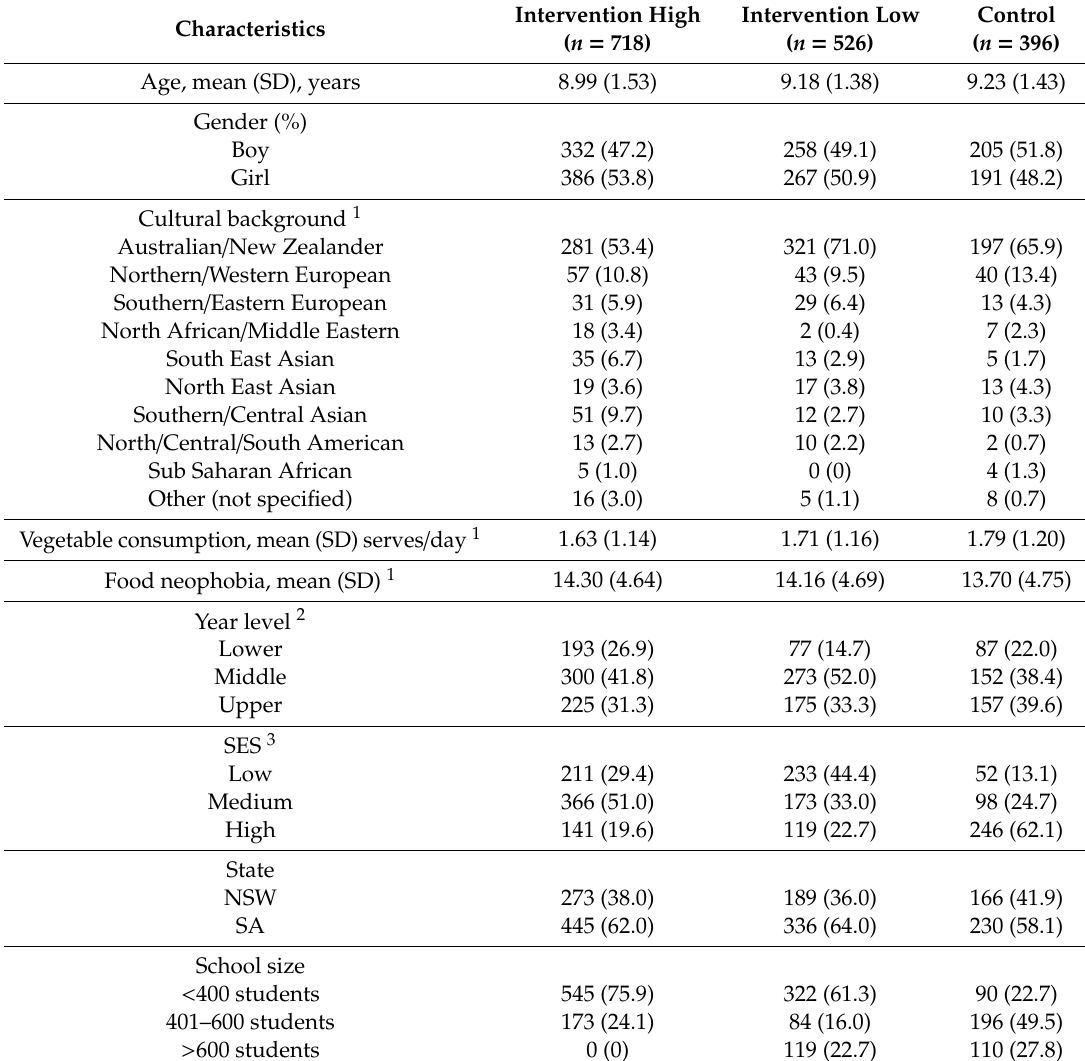
Table 2. Baseline characteristics of the individual student participant level by randomized group, high-intensity teacher training followed by vegetable education (intervention high), low-intensity teacher training followed by vegetable education (intervention low), or regular classroom education